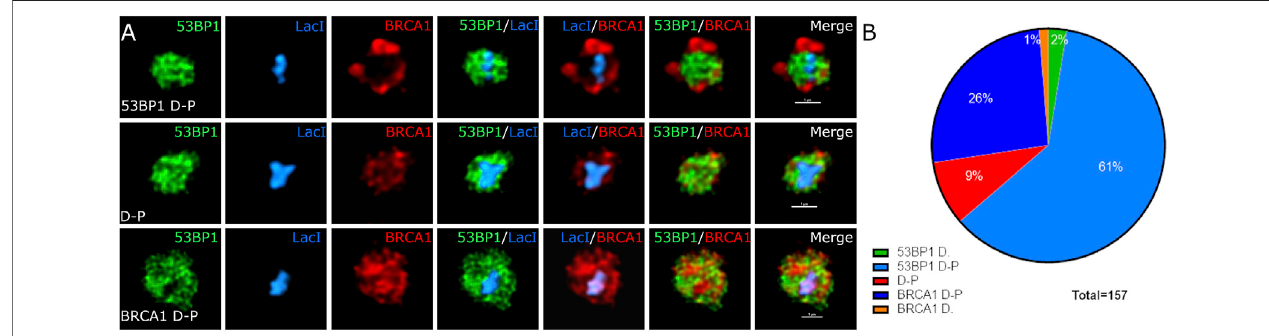
FIGURE6| ThesiteofDNAdamageandrelativeproteinsoccupyspeci fi cspatiallyresolvedsites.U2OS265cellsweretreatedwith4-OHTandShield1toallowthe translocation of mCherry – Fok1 – Lac repressor to induce the DSB. Antibodies targeting 53BP1 and BRCA1 were used to determine recruitment to the DSB. (A) BRCA1 in green, 53BP1 inred,and Lacrepressor inblue. Lightning — adaptive deconvolution (Leica) — wasused toimprovetheresolutionand image quality. (B) Theproportion of cells in 53BP1-dominant cell (53BP1 D), 53BP1-dominant double-positive cell (53BP1 D-P), 53BP1 – BRCA1-positive cell (D-P), BRCA1-dominant double- positive cell (BRCA1 D-P), and BRCA1-dominant cell (BRCA1 D) is also shown. The images were further magni fi ed 400% using interpolation. The scale bar represents 1